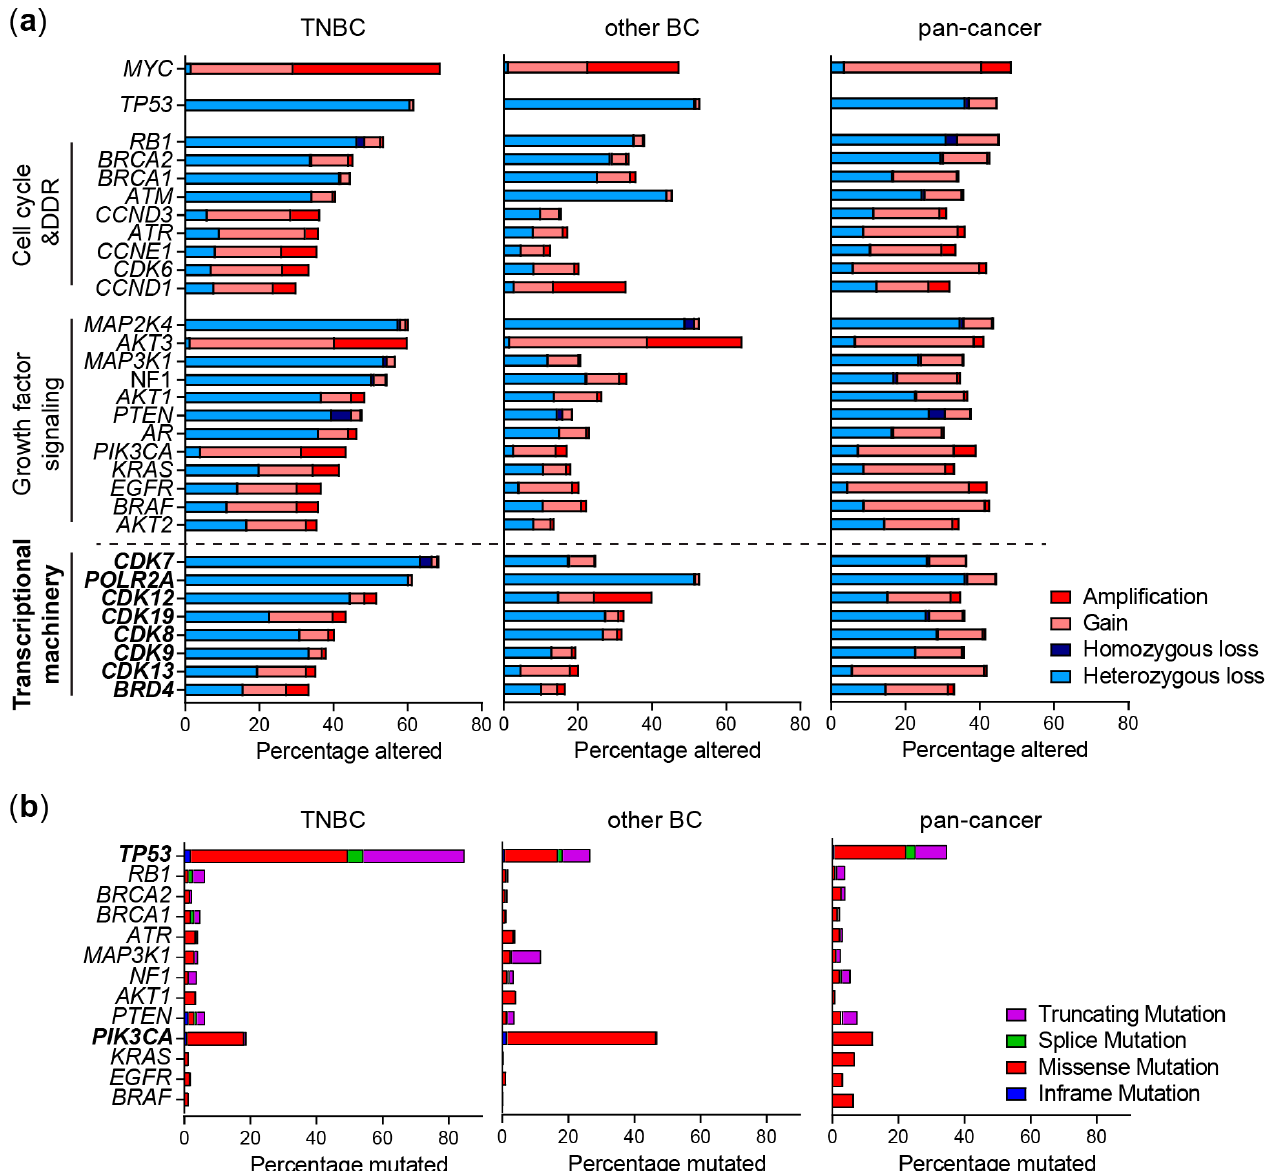
Figure 1. Genomic alterations of frequently altered pathways and the transcriptional machinery (TM) in TNBC. ( a ) Copy number alterations and ( b ) mutations in genes from TNBC patients from the METABRIC study (TNBC and other BC) or TCGA (pan-cancer) derived from cBioportal. Shown are the most frequently altered genes within cell cycle, DNA damage response (DDR) and growth factor signaling pathways.